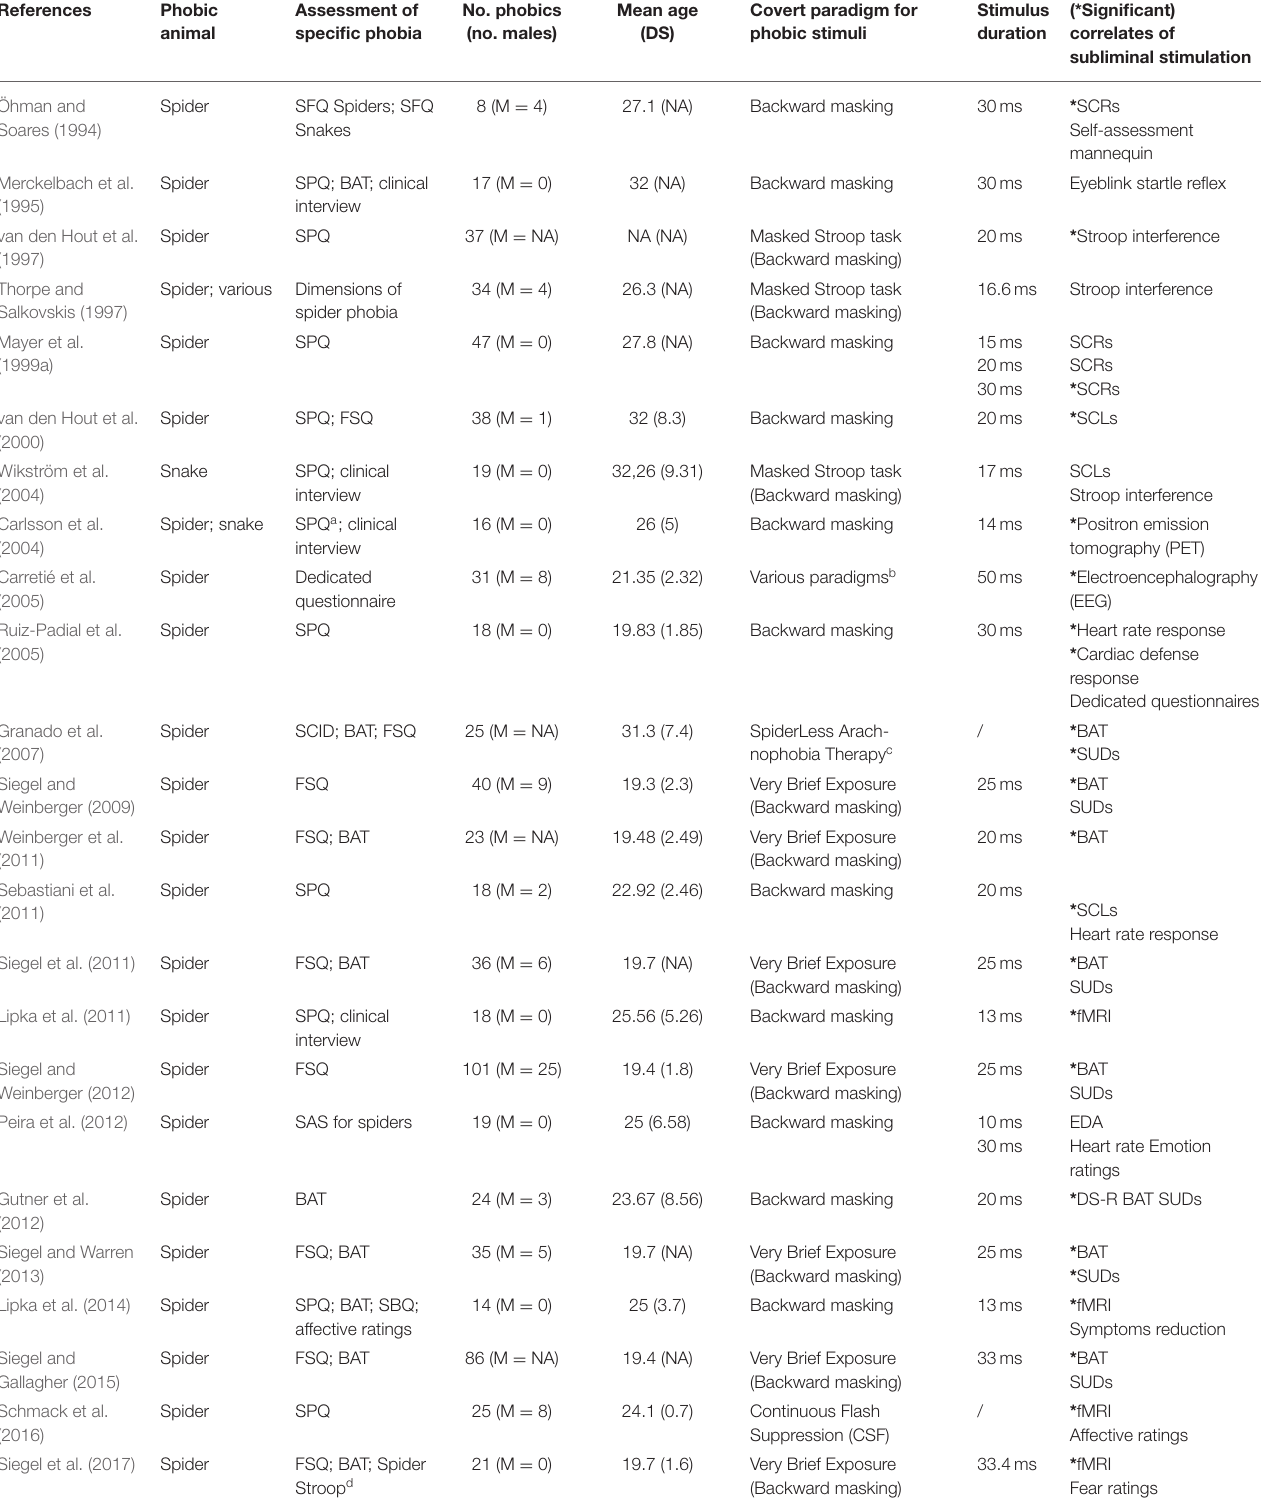
TABLE 3 | Retrieved studies and their main